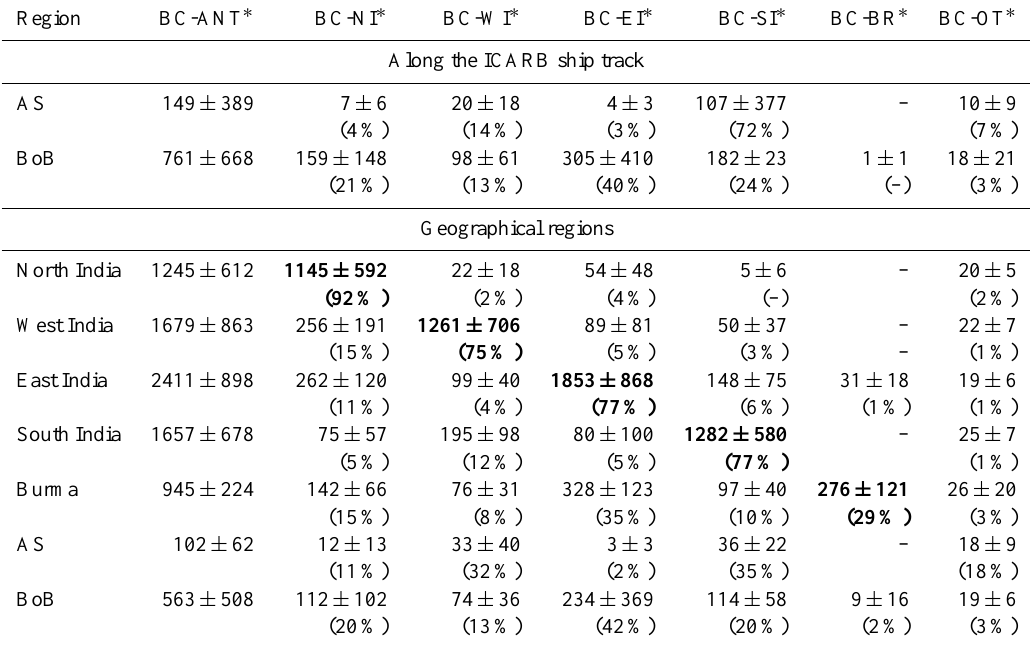
Table 3. Near-surface mass concentration (ngm − 3 ) of total anthropogenic BC (BC-ANT) and different anthropogenic regional BC tracers during the ICARB period along the ship track in the AS and BoB and over seven geographical regions. Percentage contribution of each tracer to BC-ANT is also given in parenthesis. All numbers are rounded off to the nearest whole number value. Numbers in bold font represent the contribution of local sources to the anthropogenic BC mass concentration of that region. BR and OT represent Burma and other regions,